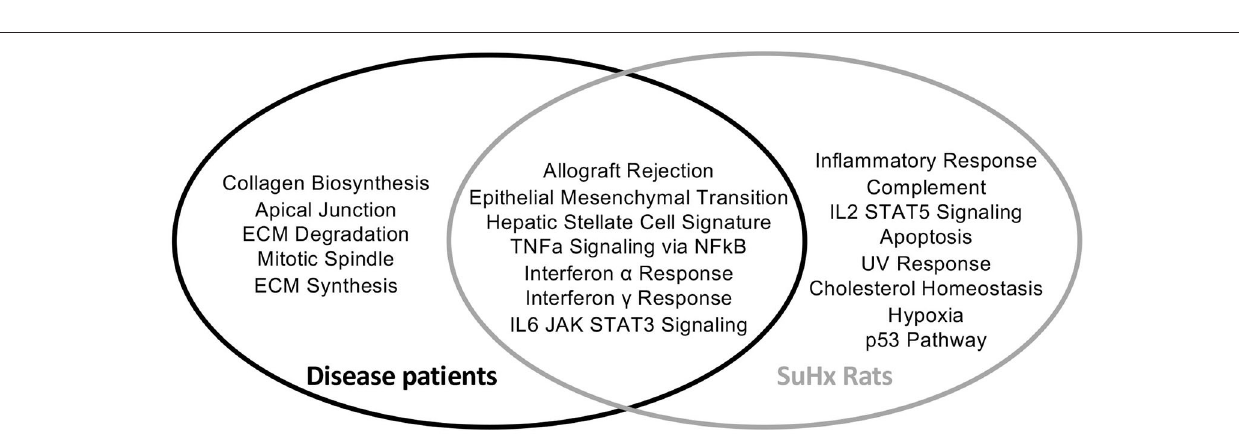
FIGURE 8 | Liver biopsies of patients with underlying heart/lung disease and PAH rats show similarities in upregulated fibrotic pathways. Venn diagram of differentially regulated pathways in disease patients and SuHx treated rats compared to their respective controls. Disease patients n = 6, SuHx Rats n =